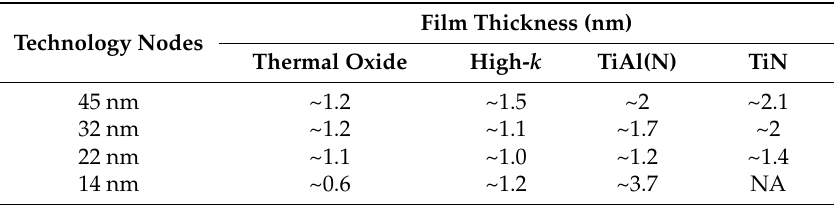
Table 4. Key parameters of high- k dielectric and metal gate from 45 nm to 14 nm nodes. Film Thickness (nm) Technology Nodes Thermal